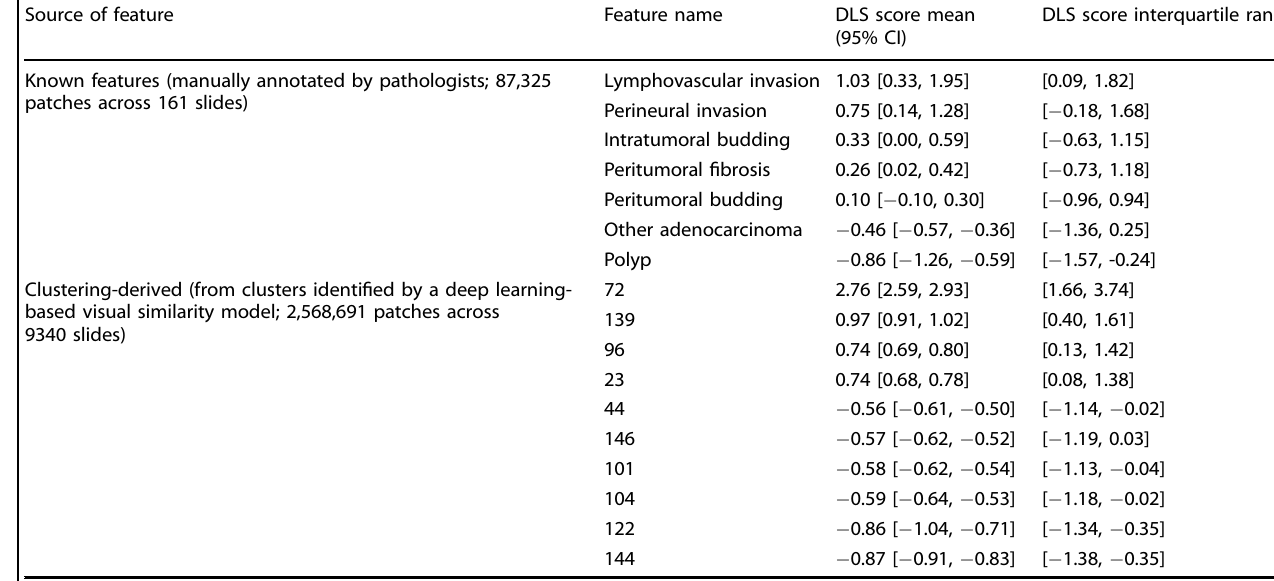
Con fi dence intervals were computed via block